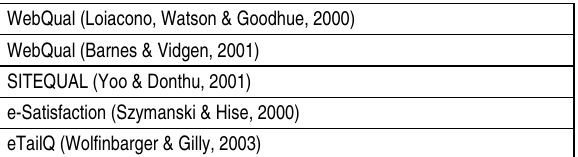
Table 2. E-service quality